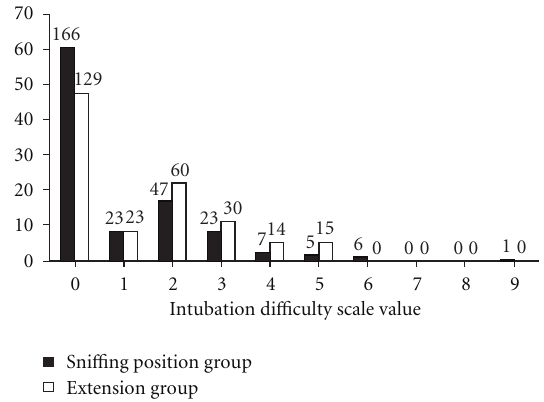
Figure 1: The distribution of Intubation Di ffi culty Scale scores among patients in the sni ffi ng position and the simple head extension group. The absolute numbers of patients is shown above each vertical